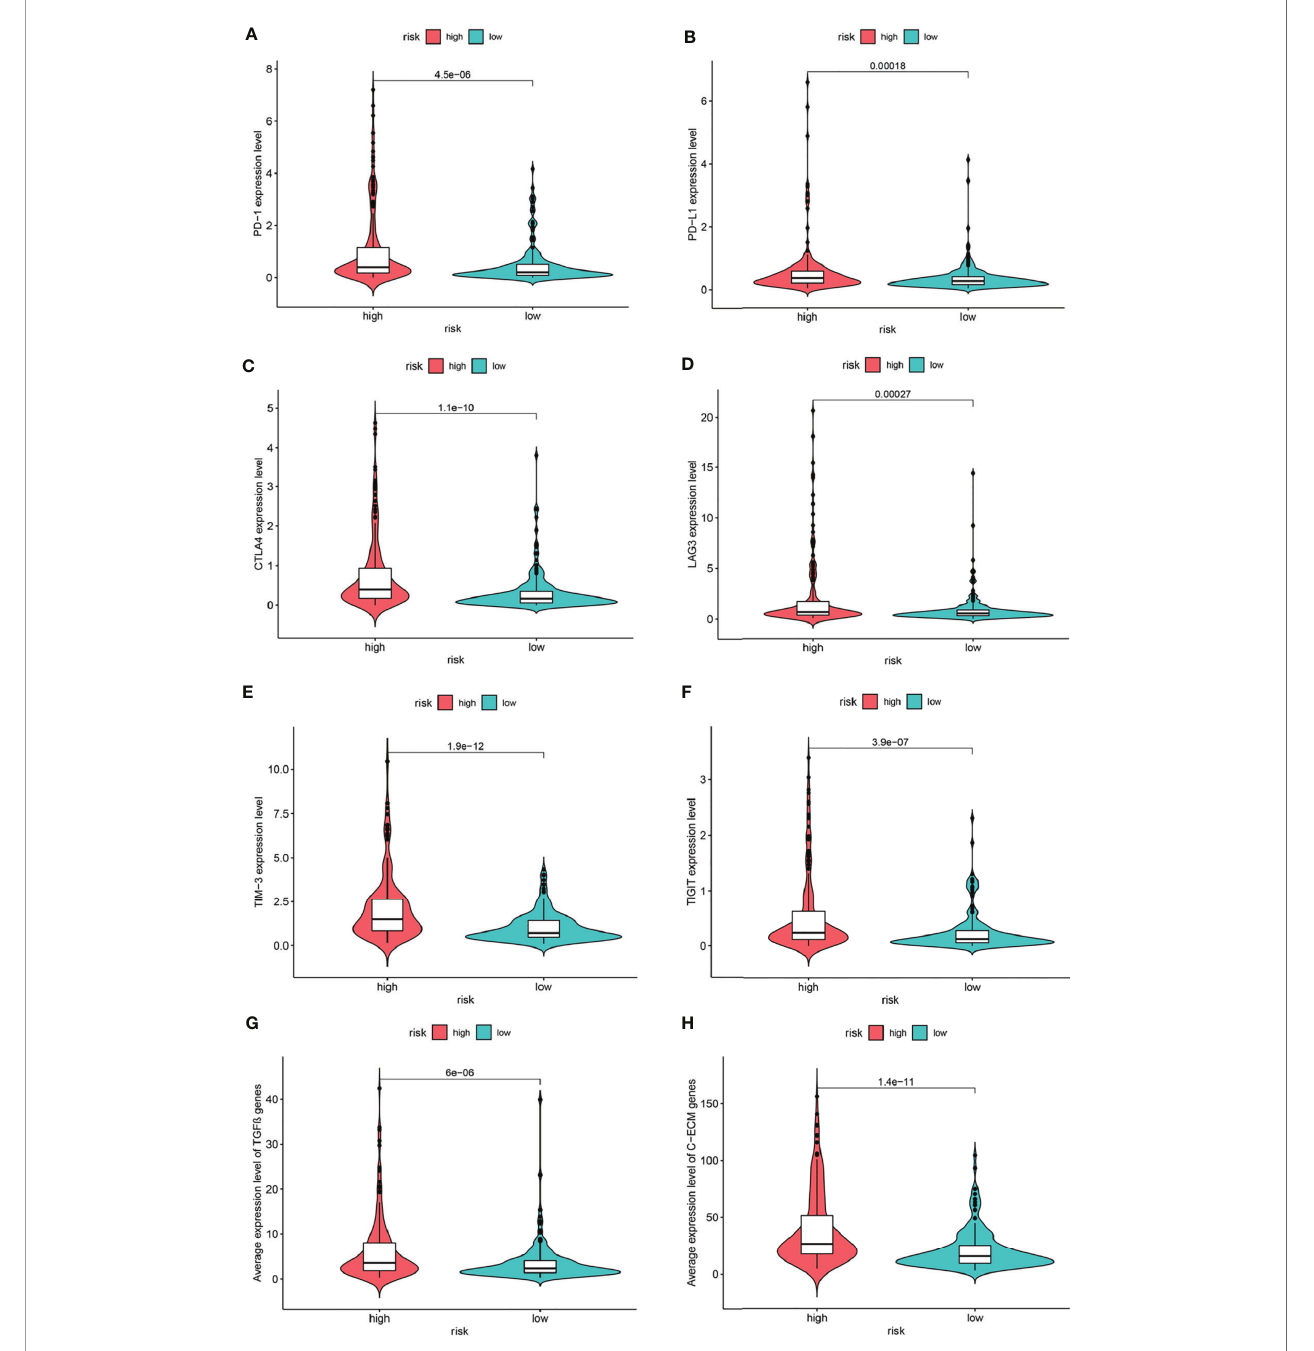
FIGURE 8 | Expression of immune checkpoints (A – F) , TGF- b – encoding (G) and C-ECM (H) signature